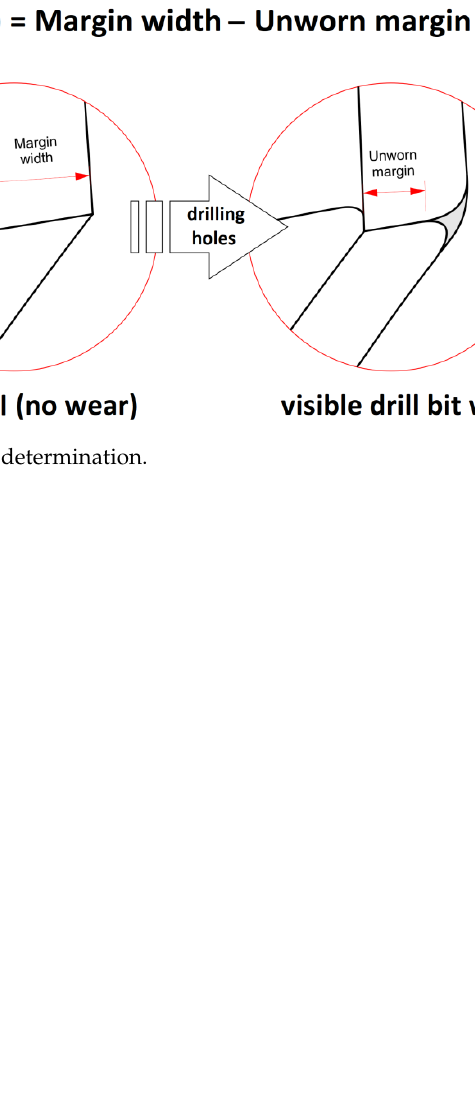
Figure 8. The experimental schedule as a standard flowchart; that is, in a metaphorical form (as if it were an algorithm of a computer program and not a procedure performed by a human